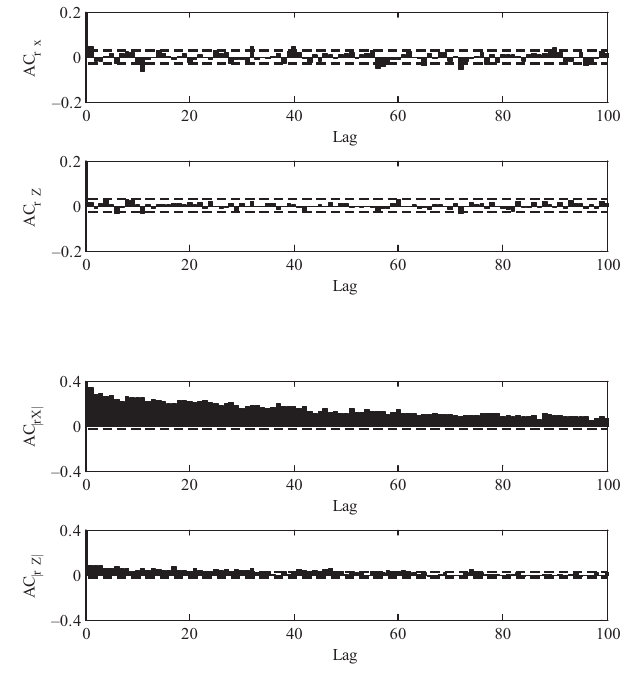
Figure 6. Autocorrelation in absolute returns of the two